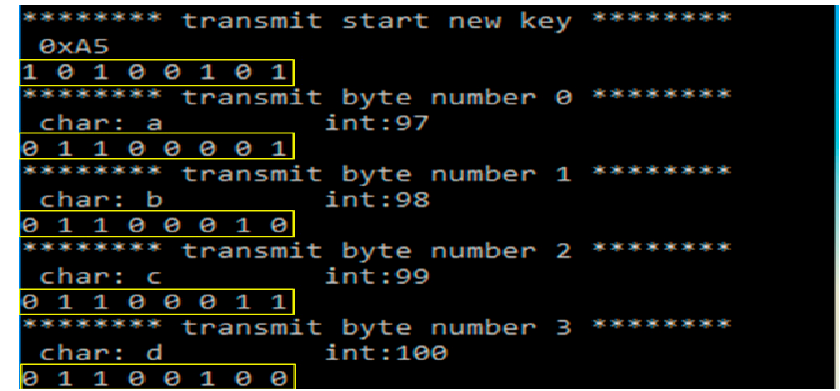
Figure 11. The code for transferring the Encryption Key to the USB.